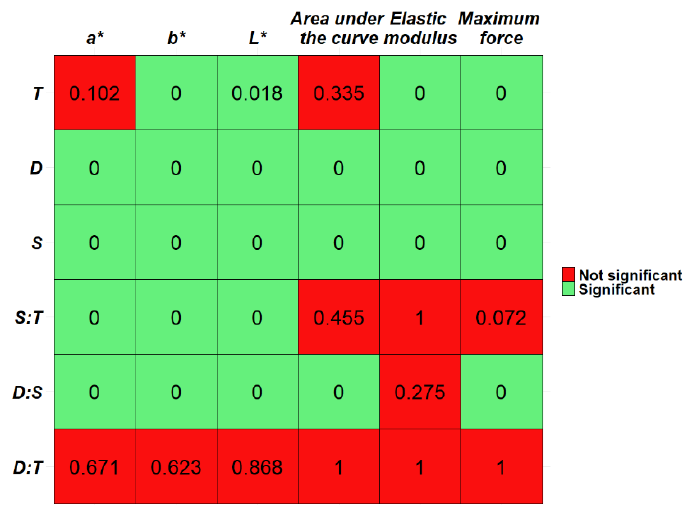
Figure 2. Tile plot reporting the p values estimated from the permutation tests for the significance of each factor (“T”: Time, “D”: Dairy Factory, “S”: Sampling Position, “S:T”: interaction between Sampling Position and Time, “D:S”: interaction between Dairy Factory and Sampling Position, “D:T”: interaction between Dairy Factory and Time) of the linear mixed models.